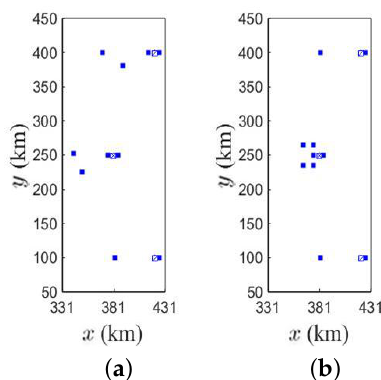
Figure 20. Empirical deployment plan of defense stations against ( a ) slant attack formation and ( b ) pincer attack formation, with kill probability of 0.7, square with cross: major post, square with slash: minor post, blue square: defense